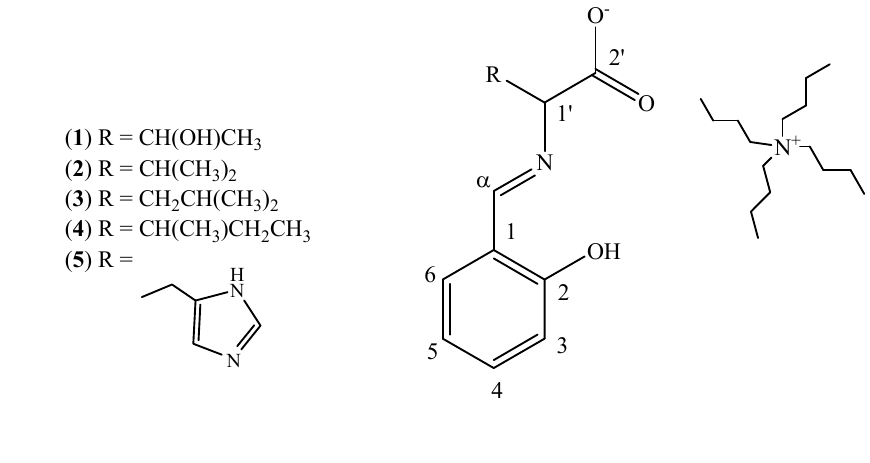
Figure 2. Amino acid ionic liquids supported Schiff bases 1 – 5